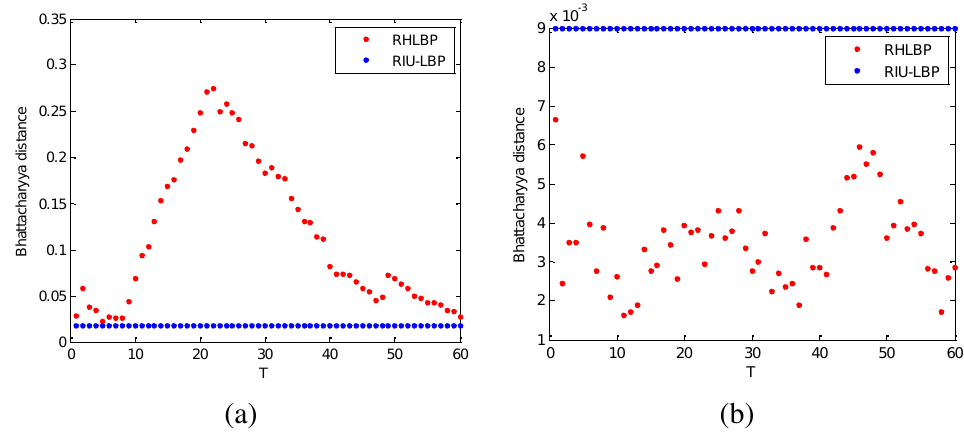
The Bhattacharyya distances of the two pairs of regions in Figure 4: ( a ) heterogeneous regions; ( b ) homogenous